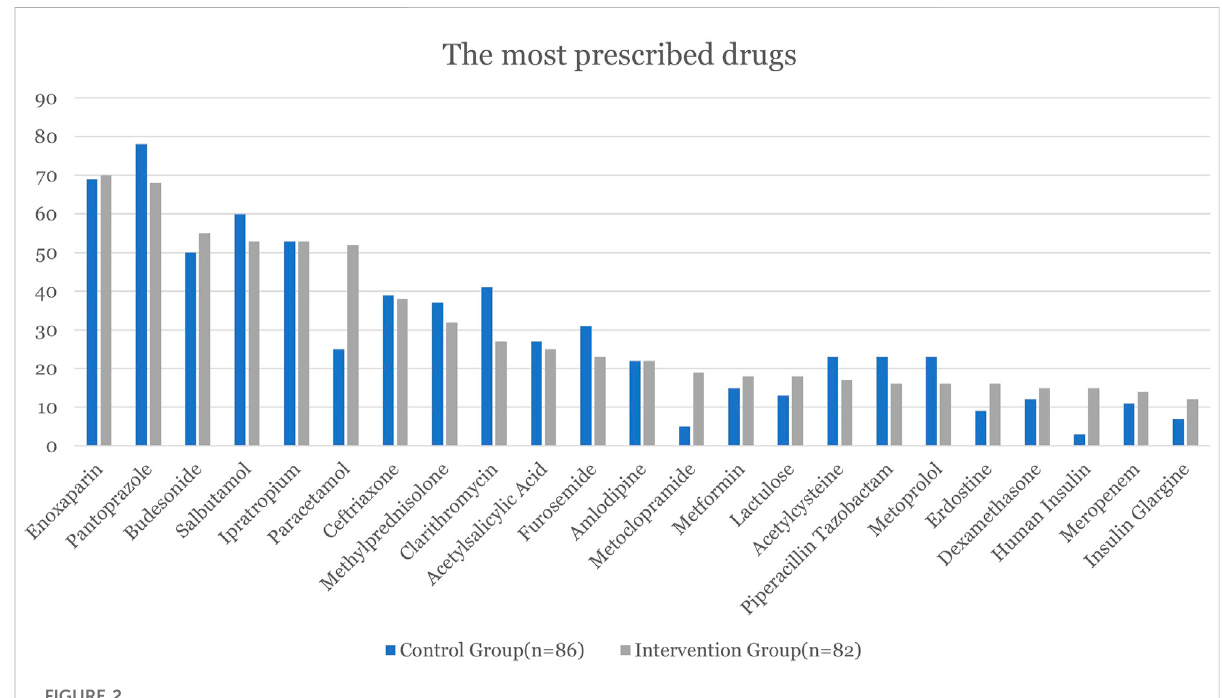
FIGURE 2 Most used drugs and the number and percentage of patients using